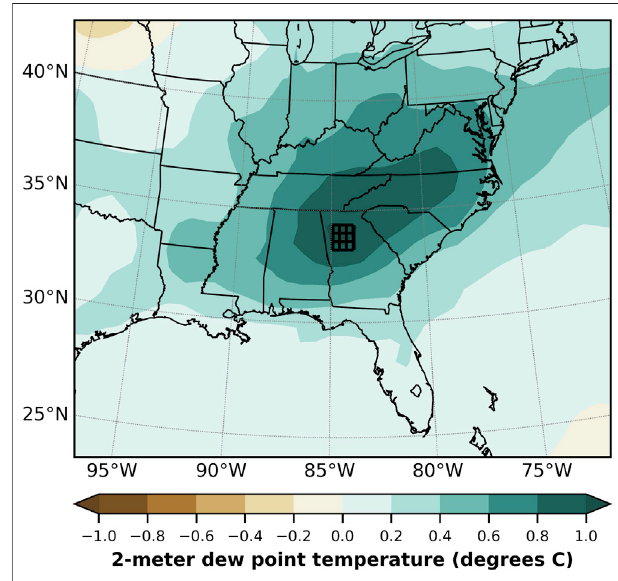
FIGURE 6 | Composite anomaly map of 2-m dew point temperature for URDs compared to non-URDs. The 9-cell gridded framework centered on Atlanta is indicated by the black-outlined boxes.